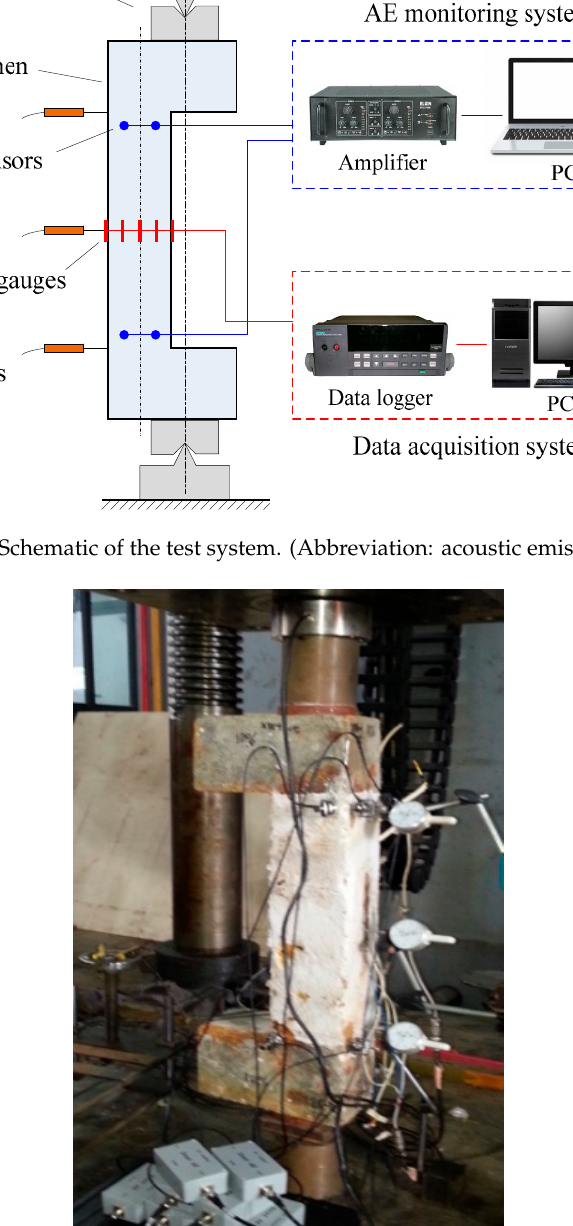
Figure 4. Photograph of the test setup.